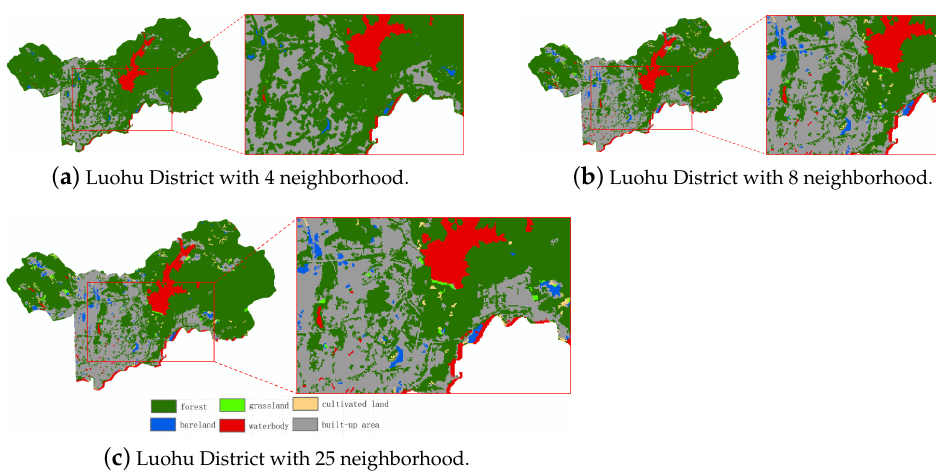
Figure 8. Land-use/land-cover prediction in Luohu District using different